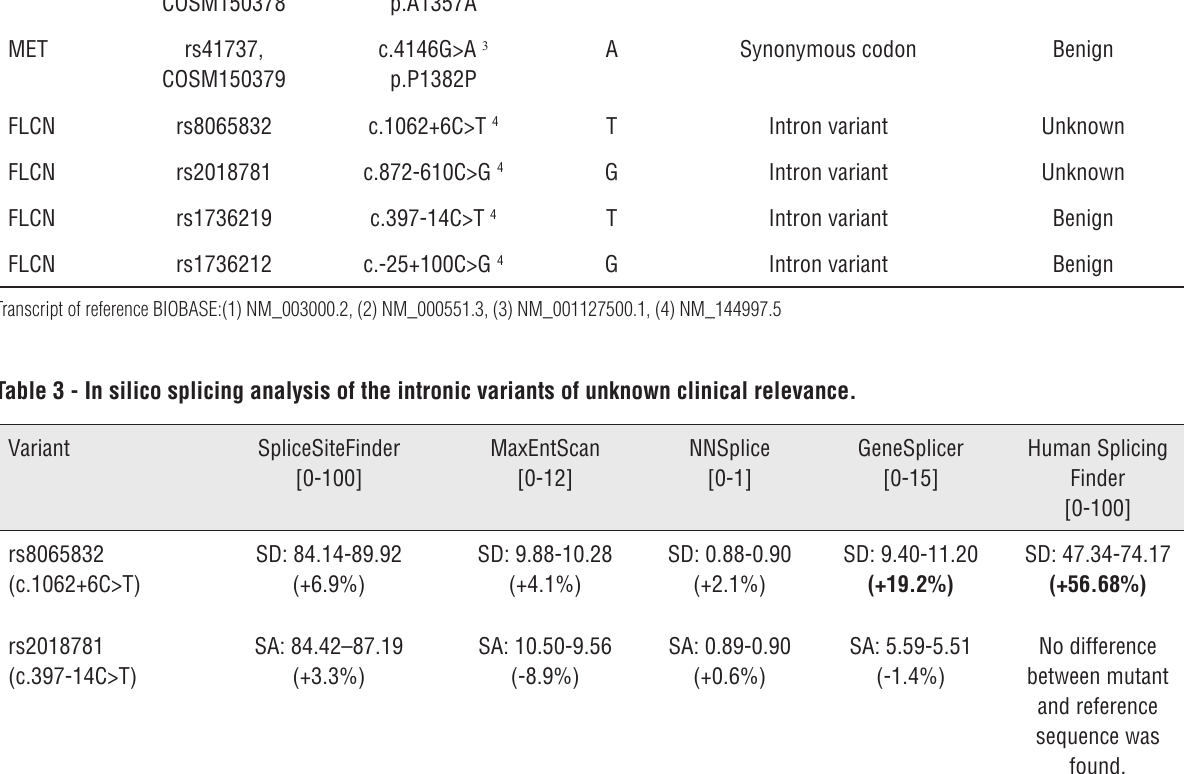
between mutant and reference sequence was